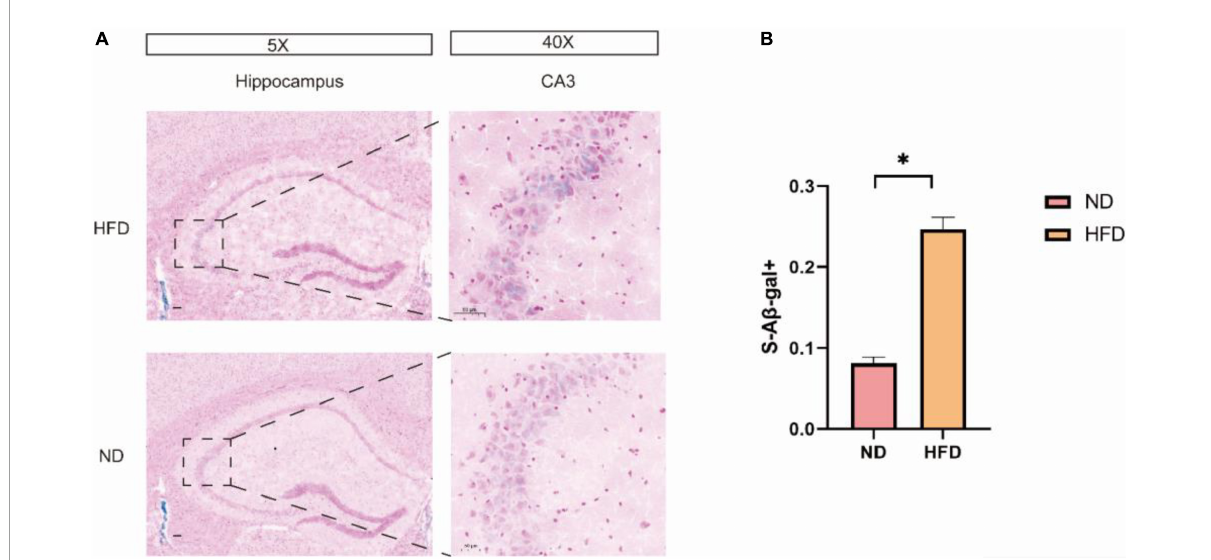
FIGURE4 A HFD induced hippocampal cell senescence. (A) Representative images of SA- β -Gal + in HFD mice and ND mice in the hippocampus. The enlarged boxed region (right) shows the region CA3-positive cells. Scale bars = 50 µ m. (B) Quantification of SA-b-GalC in total cells in the hippocampus of ND and HFD mice (n = 3/group) * p <